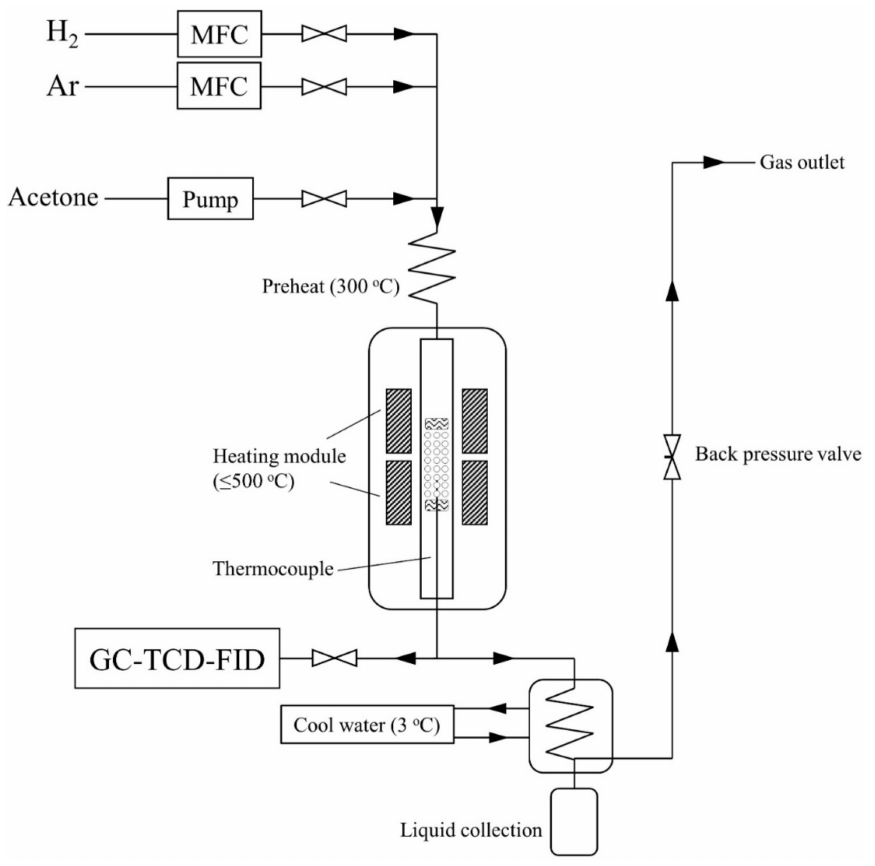
Figure 1. The diagram of fix bed reactor system.